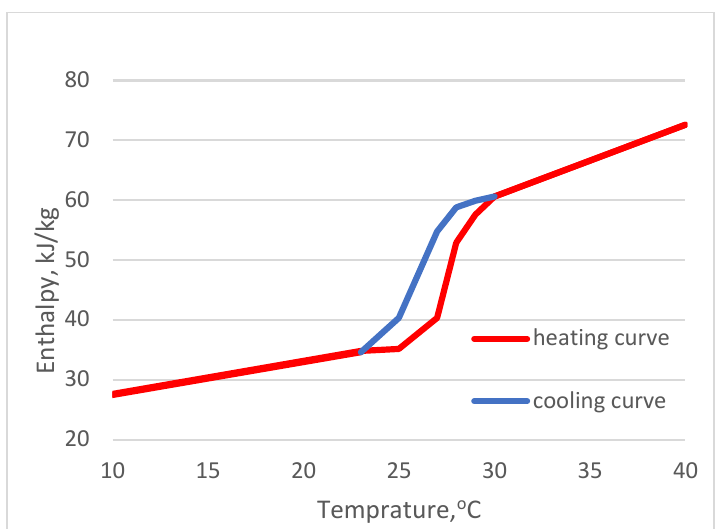
Figure 2. Temperature dependence of enthalpy for Dupont boards.